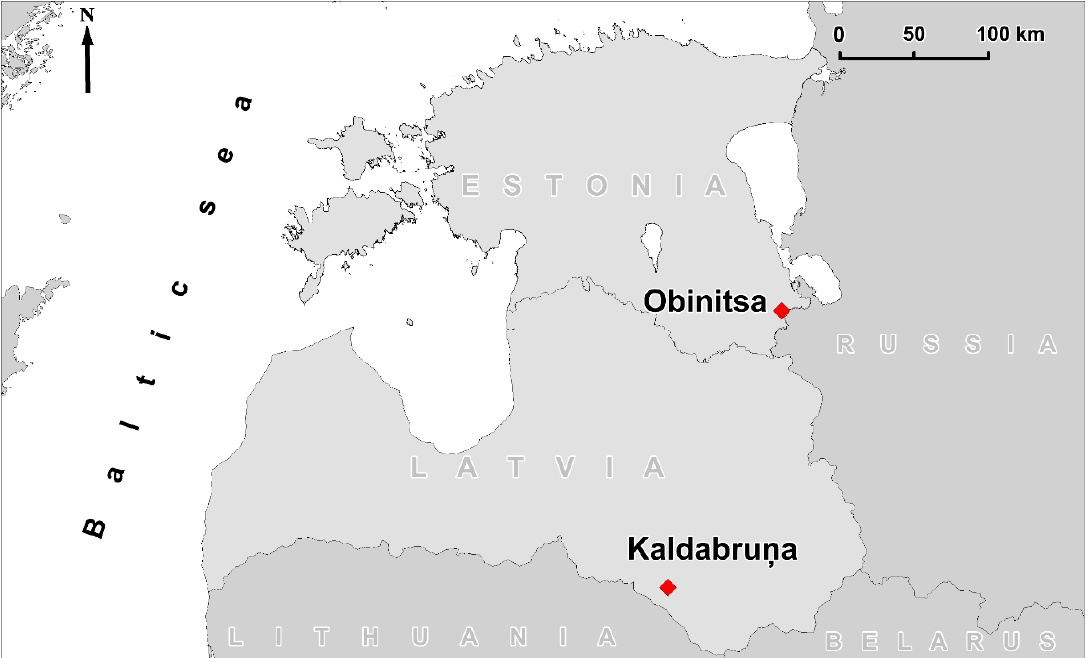
Figure 2. The case study areas of Obinitsa, Estonia, and Kaldabru ņ a, Latvia.